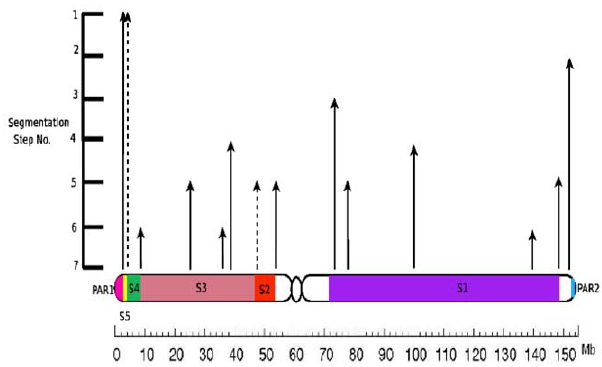
Figure 3. Segmentation boundaries in the unmasked X chromosome. The boundaries were obtained by second order Markov segmentation of the unmasked X chromosome up to the sixth step of recursive segmentation. The height of the corresponding arrows indicates the step number of segmentation. Some segmentation steps had more than one JS divergence maximum and these are indicated by the dashed arrows. (See Table S1 for the specific coordinates.).